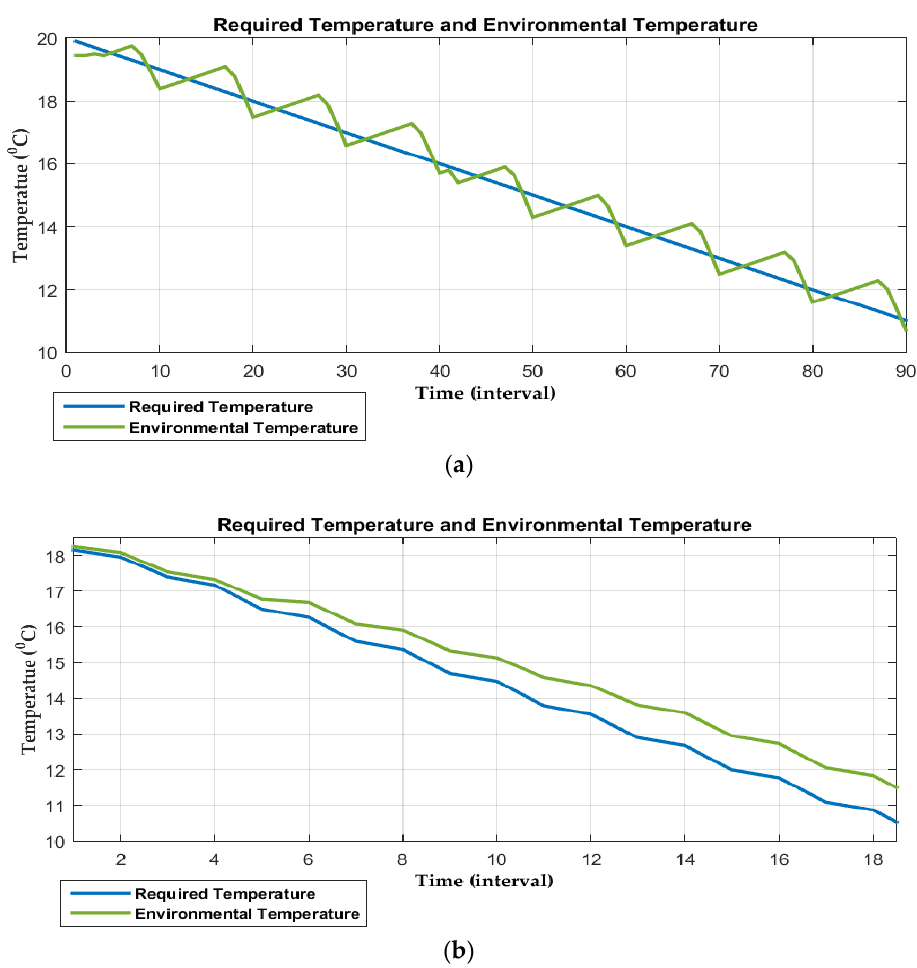
Figure 10. Proposed model results for the environmental temperature and the required temperature.